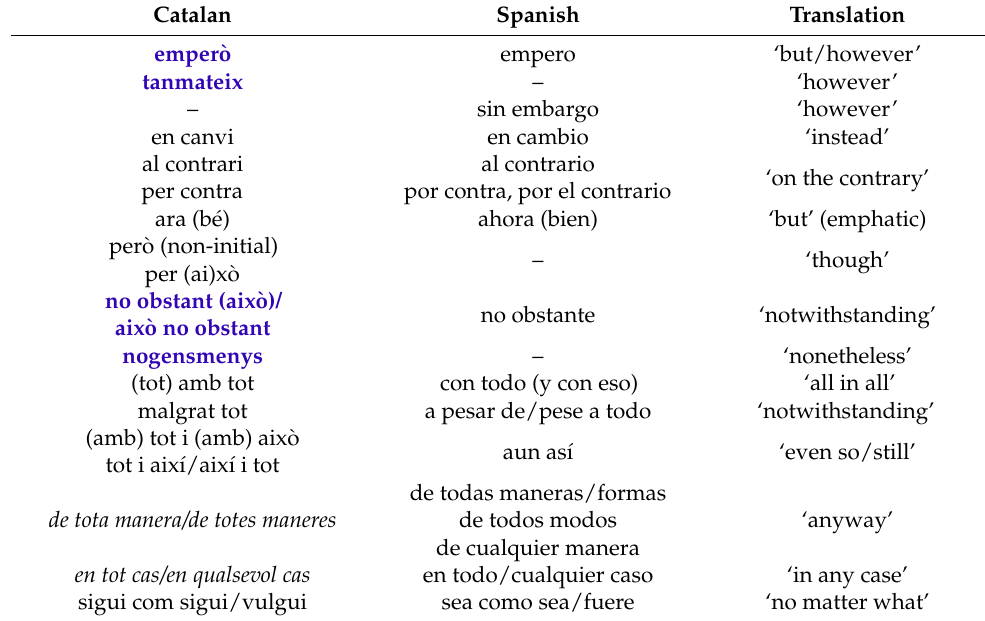
Table 1. Opposition parenthetical connectives in Catalan and